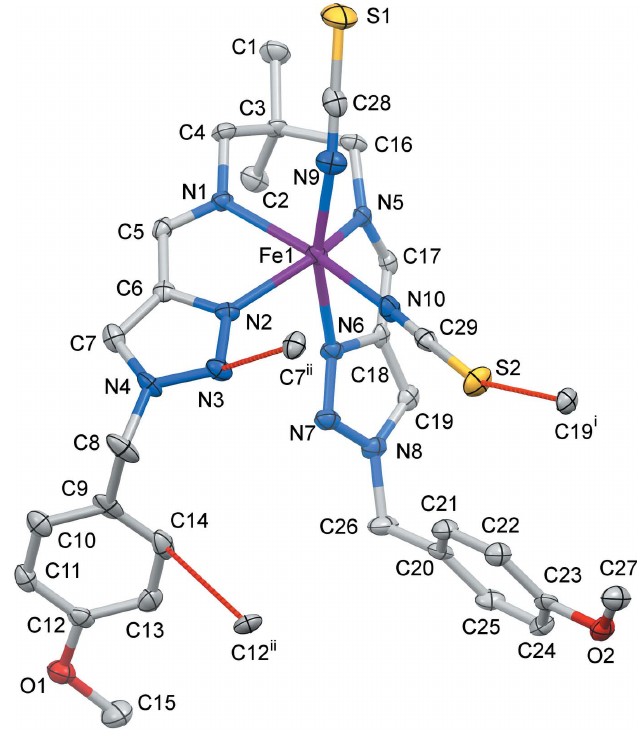
Figure 1 The molecular structure of the title compound with displacement ellipsoids drawn at the 50% probability level. H atoms have been omitted for clarity. Weak intermolecular element (cid:2)(cid:2)(cid:2) element contacts are represented by dashed red